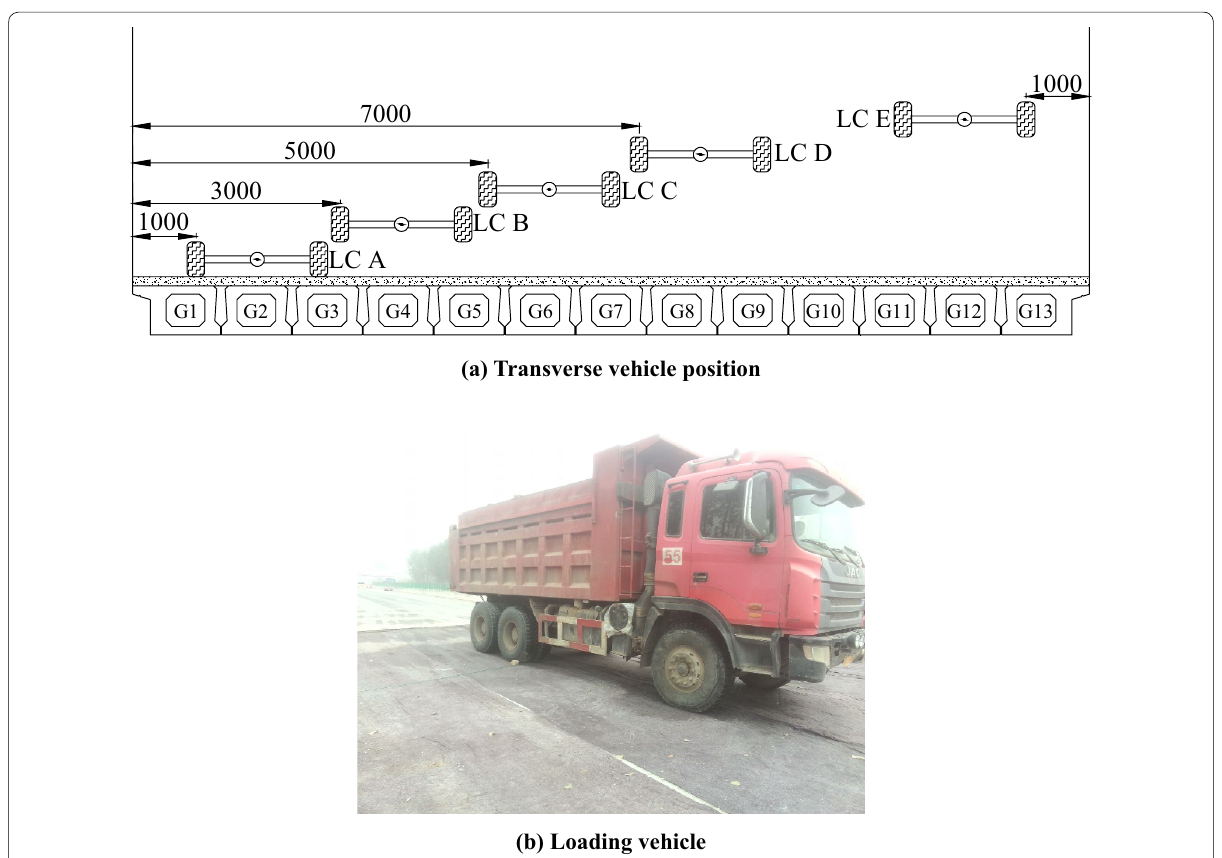
Fig. 7 Vehicle loading test configurations (units: